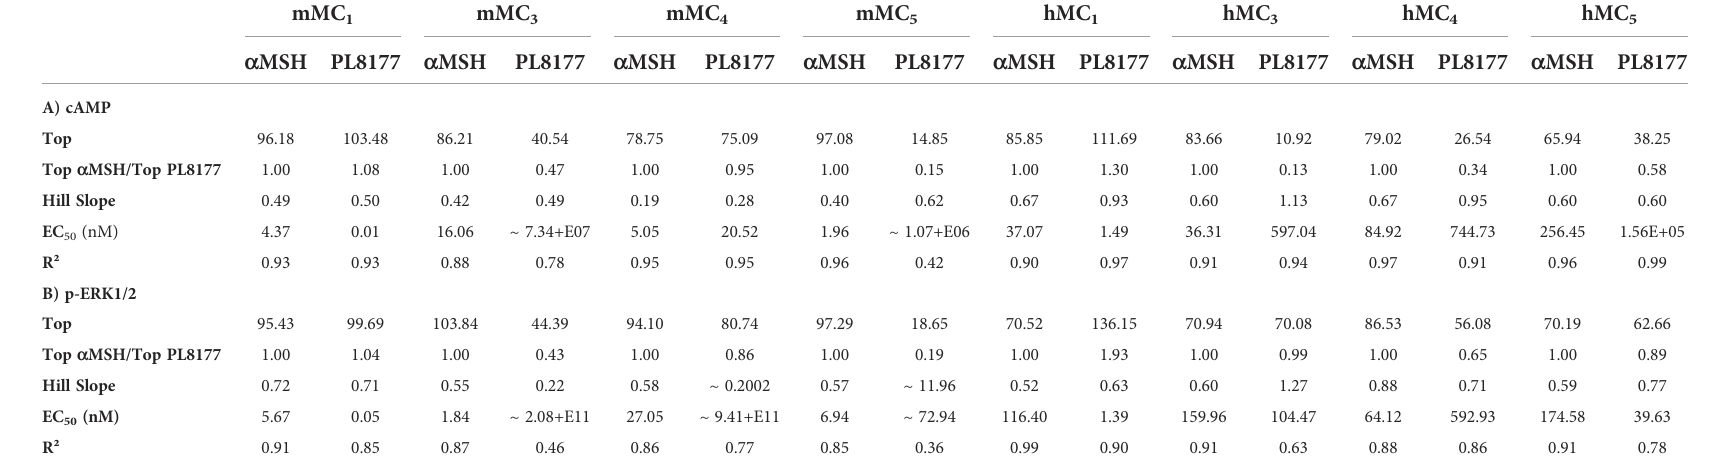
TABLE 1 Human and mouse Melanocortin receptor signaling parameters of PL8177 and a